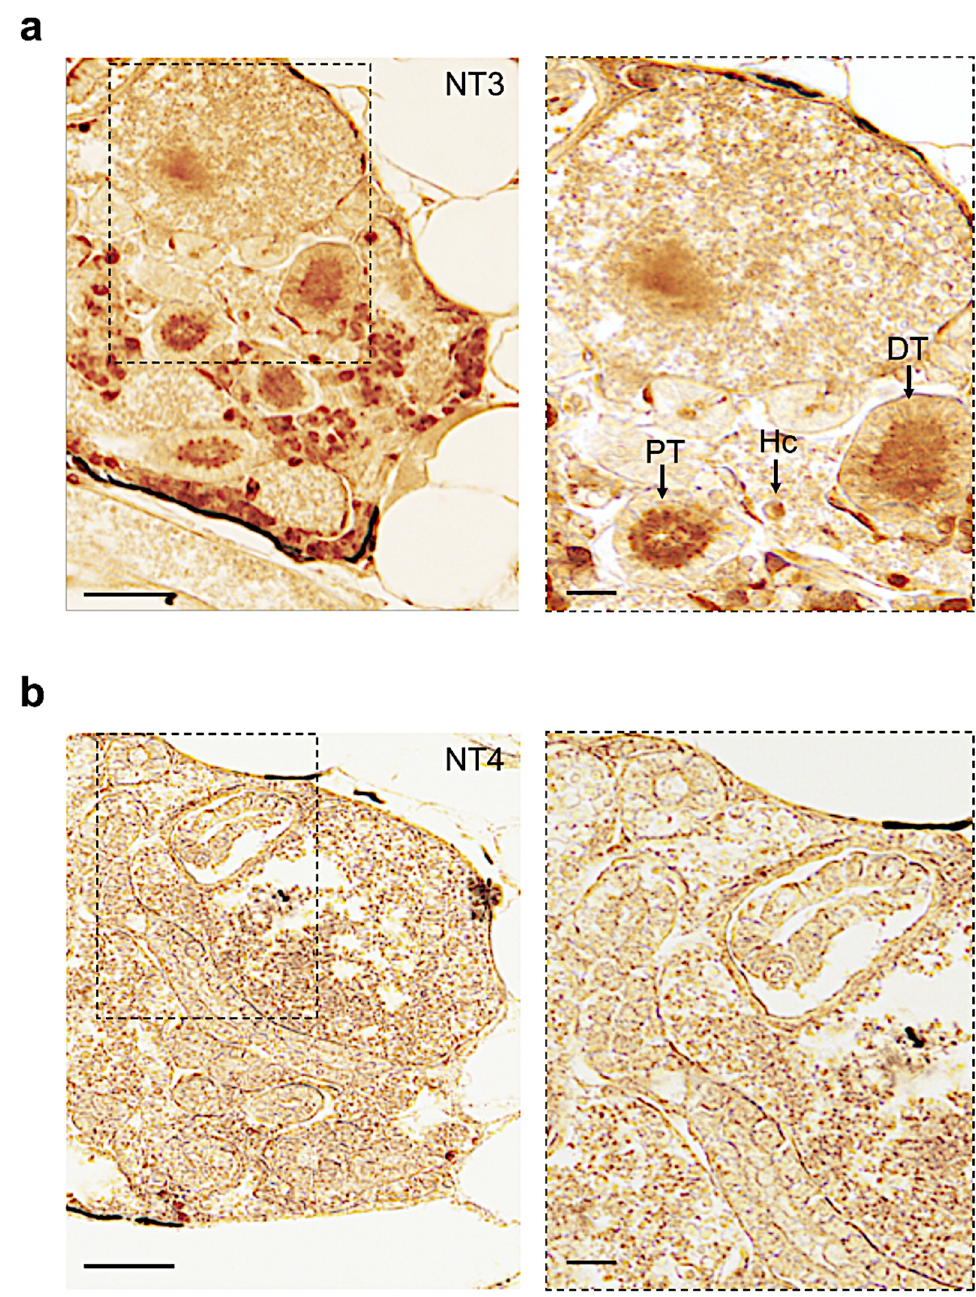
Figure 7. Immunohistochemistry to detect NT-3 and NT-4 on paraffin sections of adult zebrafish kidney. ( a ) NT-3 protein in adult zebrafish kidney is detected in distal and proximal tubules, and hematopoietic cells (DT, PT, and Hc). ( b ) NT-4 protein is not detected. Scale bars: 200 µm and 50 µm ( a , b ). All receptors were expressed in the adult zebrafish kidney in different regions.